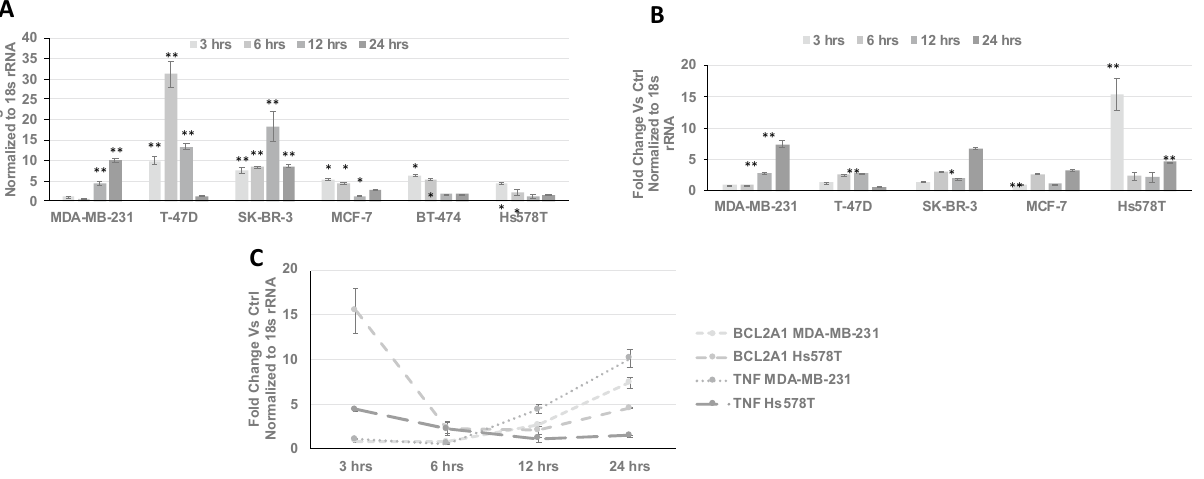
Figure 5. Differential expression TNF alpha and BCL2A1 are correlated after CHCP treatment. Line graph showing the differential gene expression of TNF ( A ) and BCL2A1 ( B ) transcripts after CAP treatment at 120 power for 5 min on TNBC cell line MDA-MB-231. The samples were normalized to 18s rRNA and the fold changes were compared to mock controls. Line graph ( C ) shows the correlation of BCL2A1 and TNF gene expression after CAP treatment at 120 power for 5 min on two TNBC cell line MDA-MB-231 and Hs578T cells. The samples were normalized to 18s rRNA and the fold changes were compared to mock controls. Error bars represent means ± SEM. Student t test significant at *p values < 0.05, *p values < 0.01.